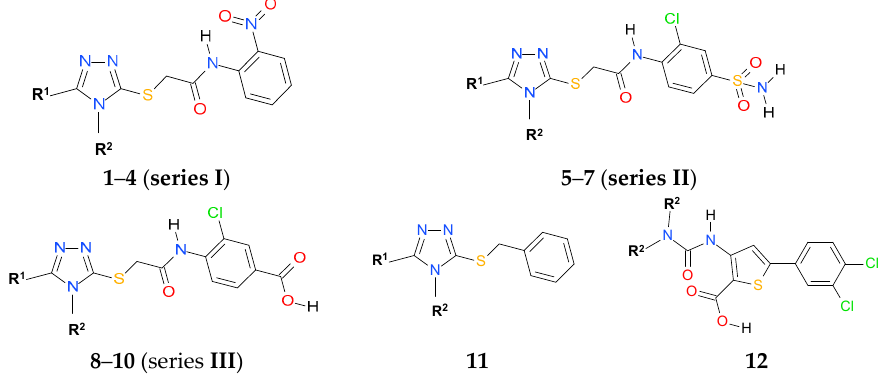
Figure 1. General structures of our recently reported triazole non-nucleoside reverse-transcriptase inhibitors (NNRTIs) [6] and thiophene-2-carboxylic acid derivative ( 12 ) with inhibitory activity against RNA polymerase (RNAP) [14].